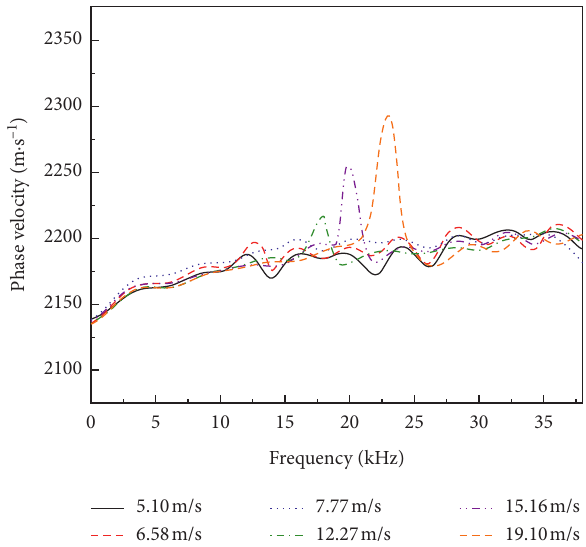
Figure 7: Relationship between phase velocity and frequency at different impact